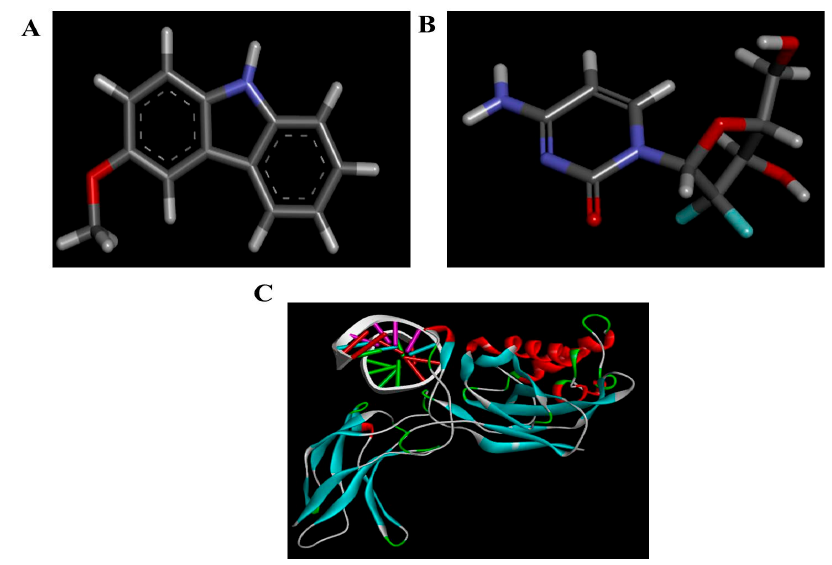
Figure 1. Three-dimensional chemical structures of ( A ) 3-Methoxy carbazole, ( B ) Gemcitabine and ( C ) NF- κ B.